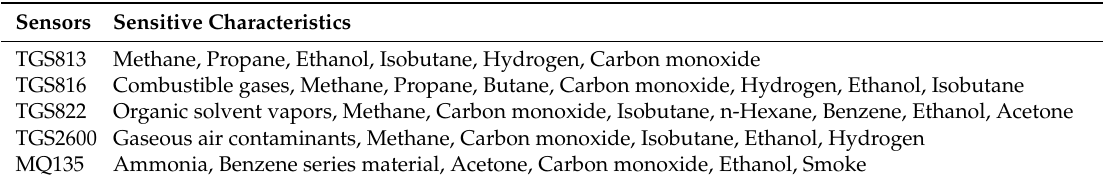
Table 1. Sensitive characteristics of gas sensors.